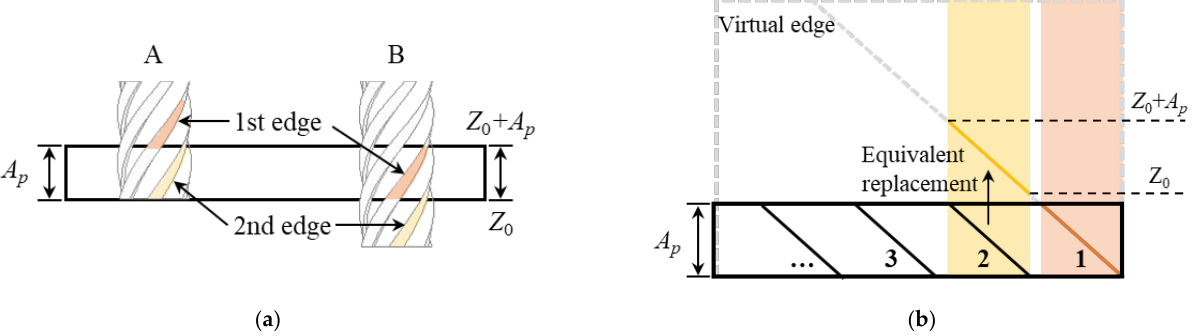
Figure 3. Transformation of the milling force: ( a ) milling at different positions with equal axial cutting depth and ( b ) the virtual-edge projection.